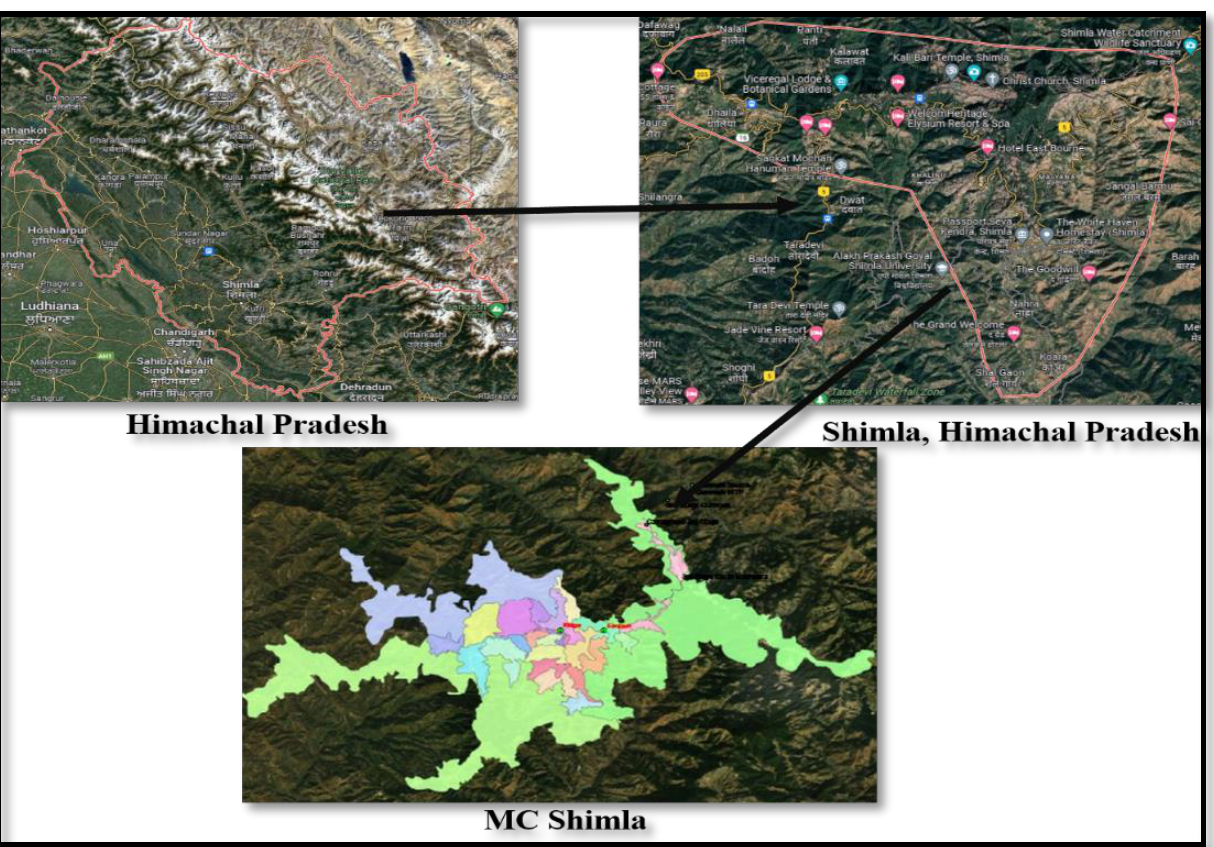
Figure 1. Geographical location of study